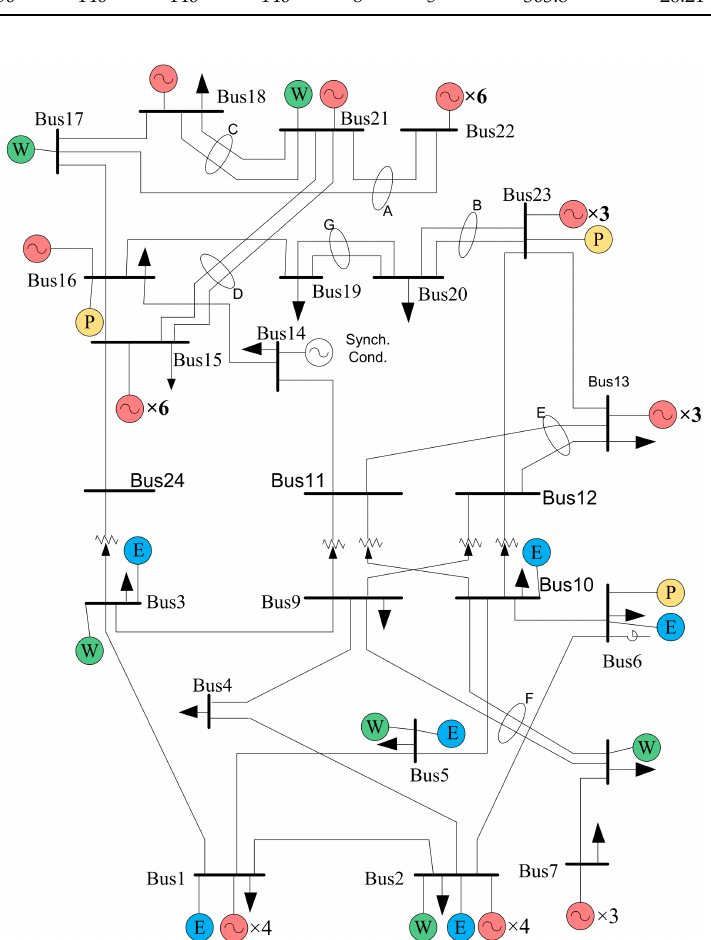
Figure 2. Schematic diagram of the